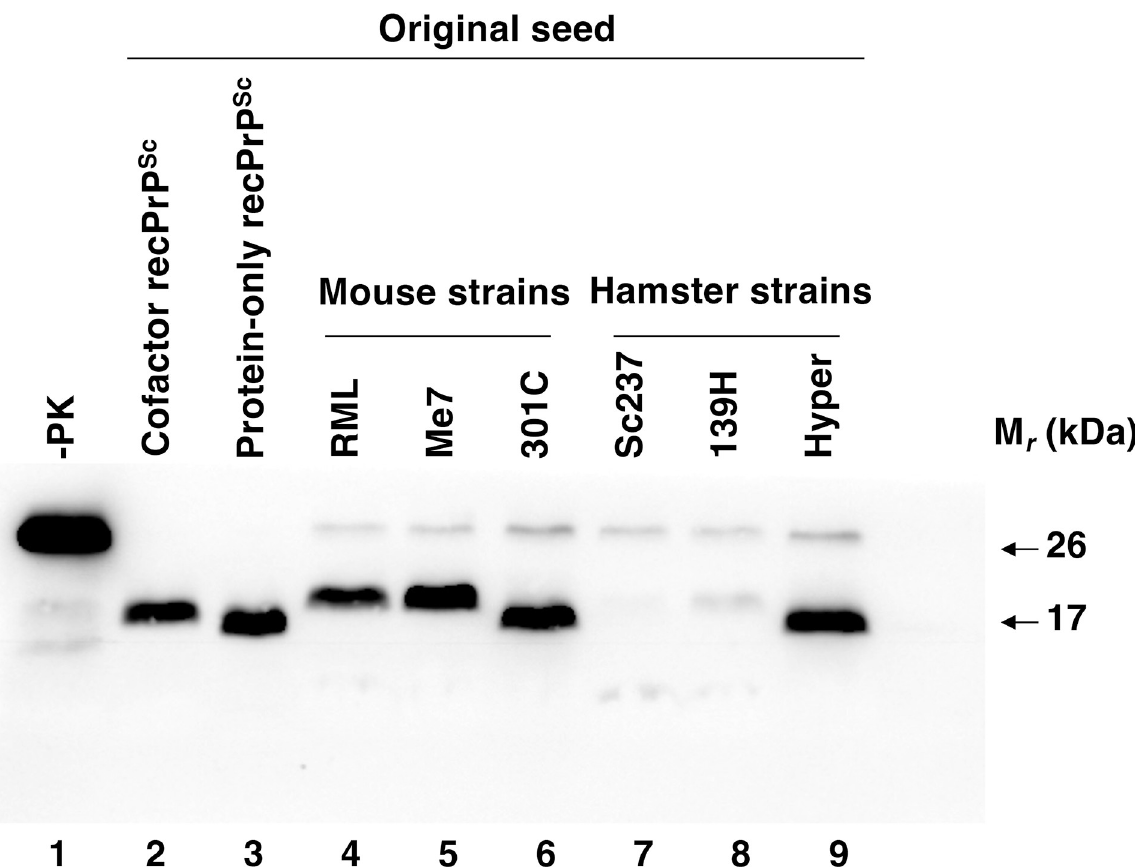
Fig 3. Shaking-generated wild-type BV recPrP Sc molecules. Western blot showing the final product of 26-round serial propagation shaking reactions containing wild-type BV recPrP substrate plus purified brain phospholipid cofactor. Each sample was initially seeded with sPMCA- generated recPrP Sc seeds (lanes 2–3), native mouse prions (4–6), or native hamster prions (lanes 7–9), as indicated. (-PK) = sample not subjected to proteinase K digestion; all other samples were